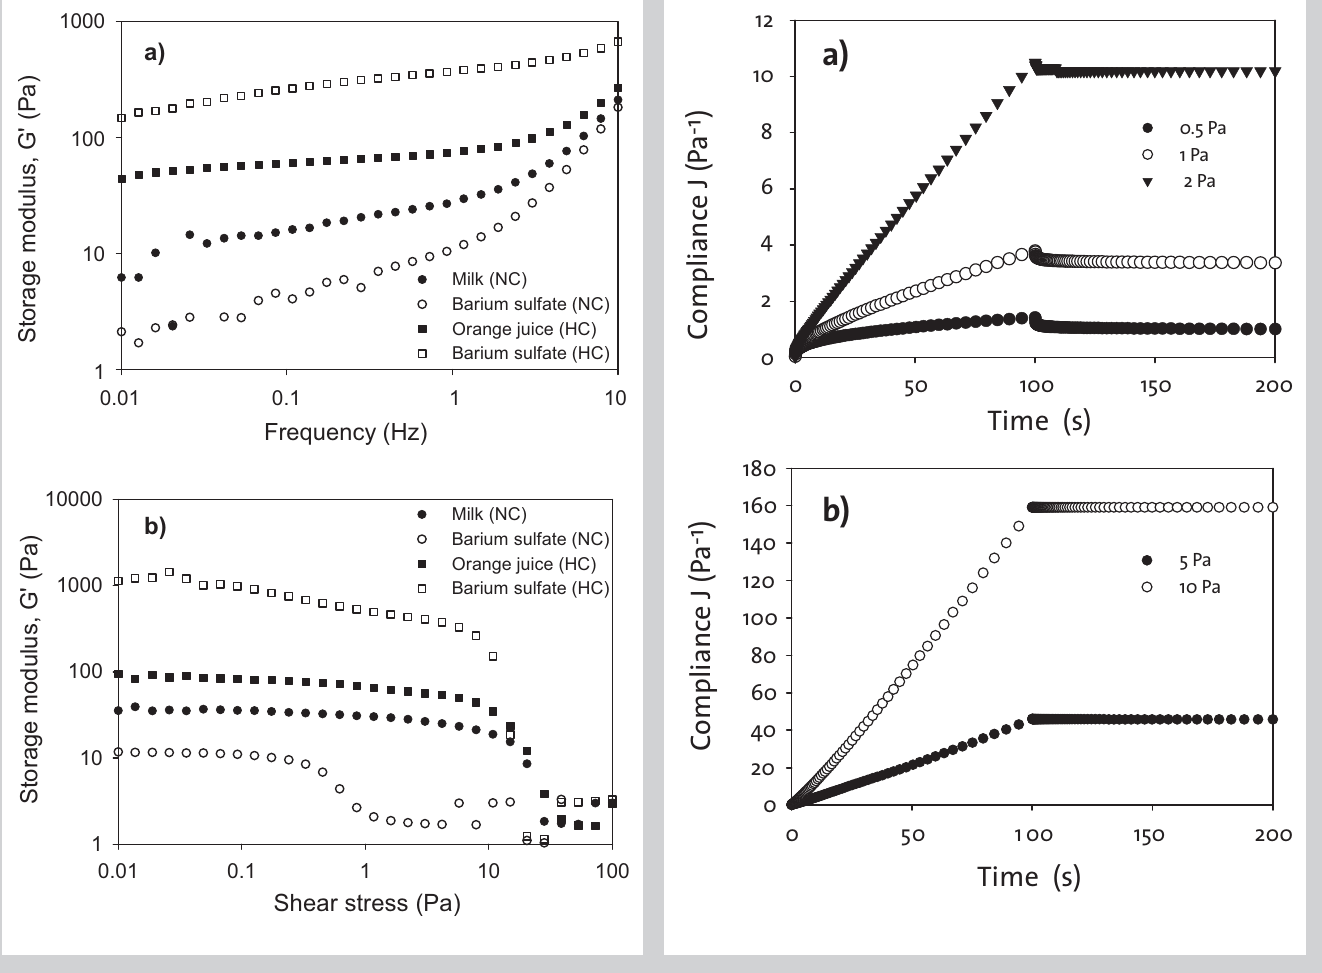
Figure 3 (left): a) Mechanical spectra of nectar consistency (NC) and honey consistency (HC) samples. b) Stress sweep data of nec- tar consistency (NC) and honey consistency (HC) samples. Figure 4: a) Creep recovery response of thickened milk with a nectar consistency at three levels of applied stress. b) Creep recovery response of thickened milk with a nectar consistency at two levels of applied